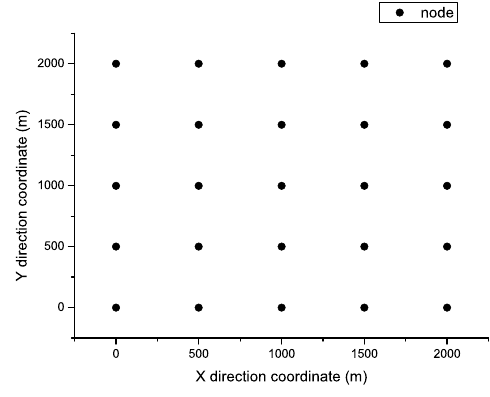
Fig.6. The locations of multi-hop nodes (static).